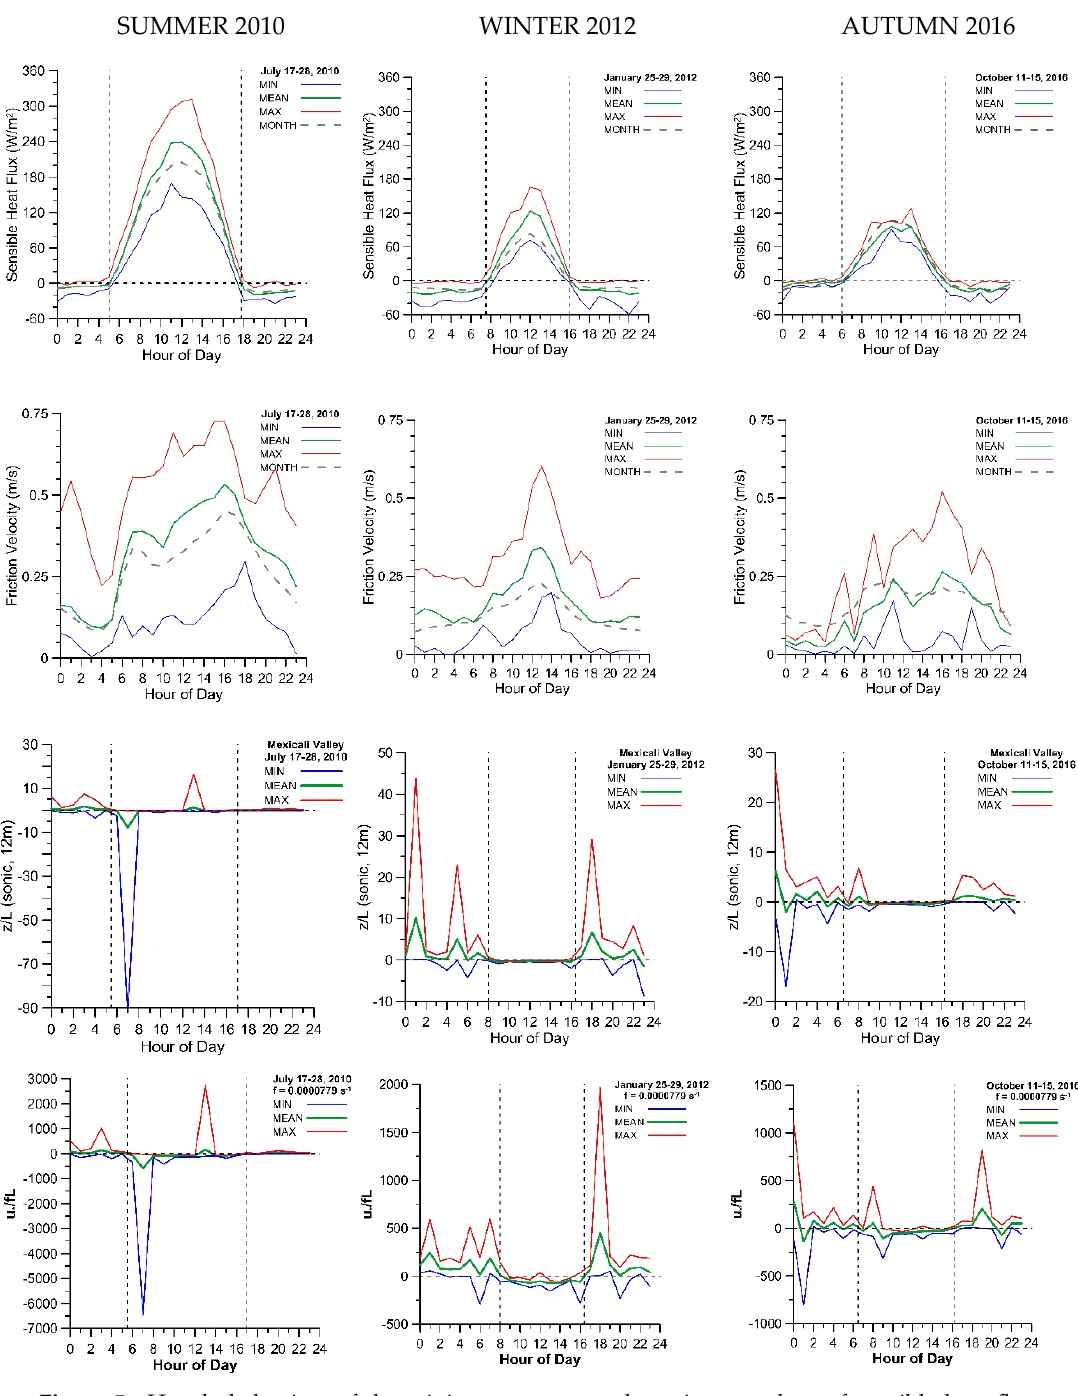
Figure 5. Hourly behaviors of the minimum, mean, and maximum values of sensible heat flux, friction velocity, and the stability parameters during the Cerro Prieto (Mexicali) summer, winter, and autumn campaigns.